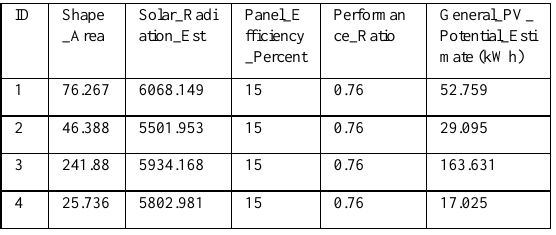
Table 1. General solar photovoltaic potential